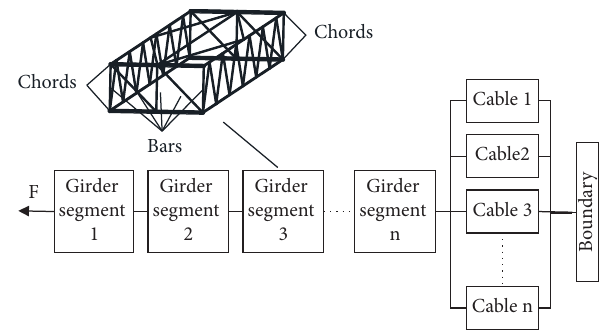
Figure 5: Series and parallel system of the cable-stayed